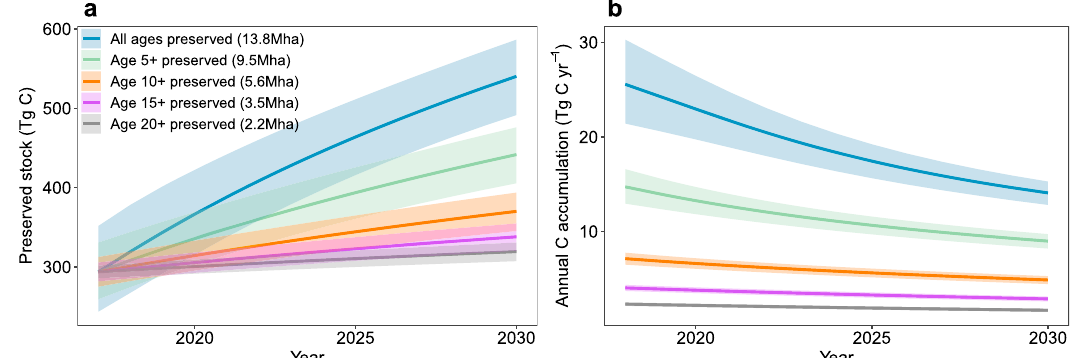
Fig. 5 The potential carbon stock and annual carbon accumulation in Brazilian Amazonian secondary forests from 2017 to 2030 based on different levels of protection of the 2017 secondary forest area. The changes to a the carbon stock, and b the annual carbon accumulation, are estimated for the coming decade, considering different scenarios of preservation of secondary forest area. Calculated using the region-speci fi c regrowth models developed in this study. Shading denotes the 95% con fi dence interval of the regrowth